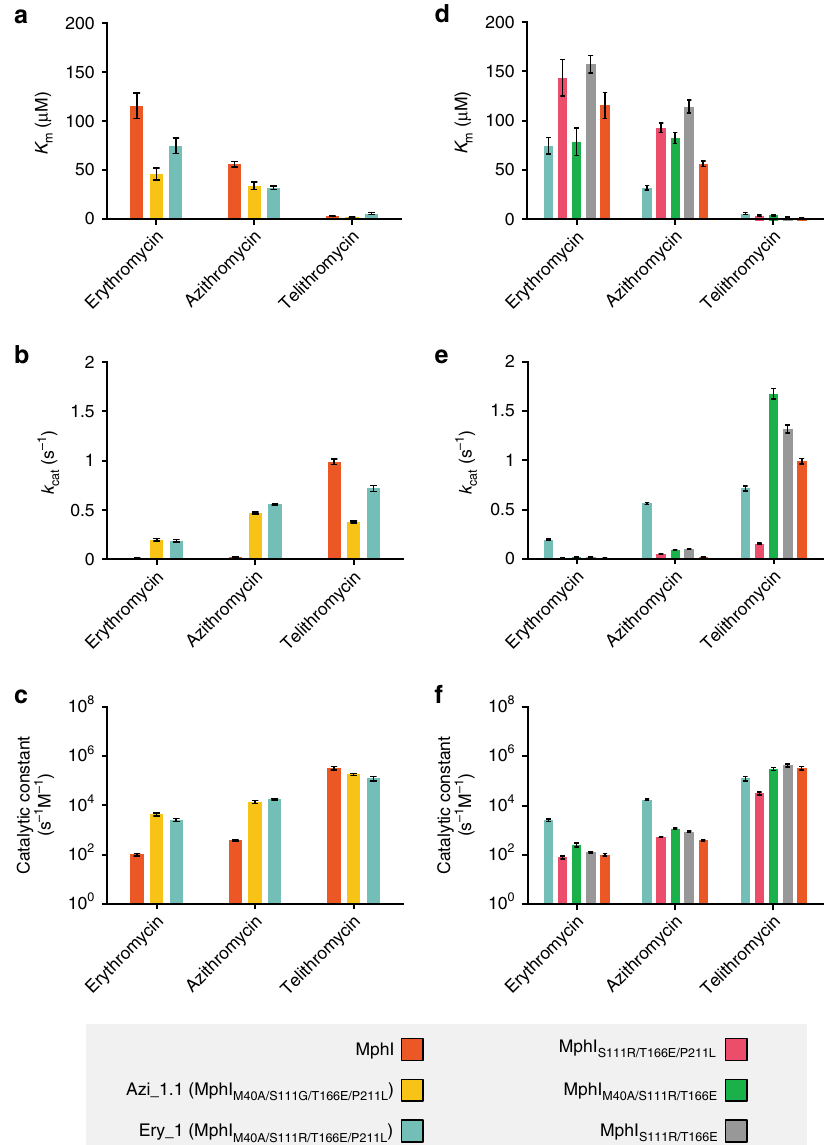
Fig. 6 Kinetic characterization of MphI and mutants with improved activity towards C3 cladinose macrolides. Steady-state enzyme kinetics for MphI library mutants ( a , b , c ) and intermediate Ery_1 mutants ( d , e , f ). a K m , b k cat , and c k cat / K m values for MphI and library mutants are presented in clustered bar graph format. d K m , e k cat , and f k cat / K m values for intermediate Ery_1 mutants are also presented. Error bars represent the standard error of the mean (s.e. m.). The y -axis for c and f are presented in log 10